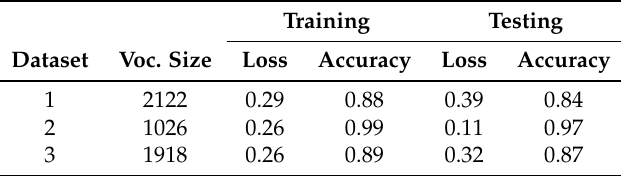
Table 9. Lex-Pos Sequence— W E O E